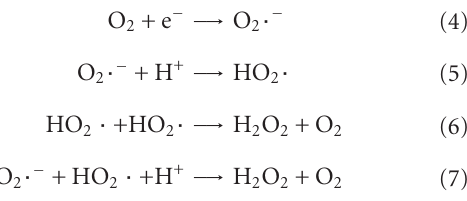
0.004 min − 1 . The typical time-dependent MCB